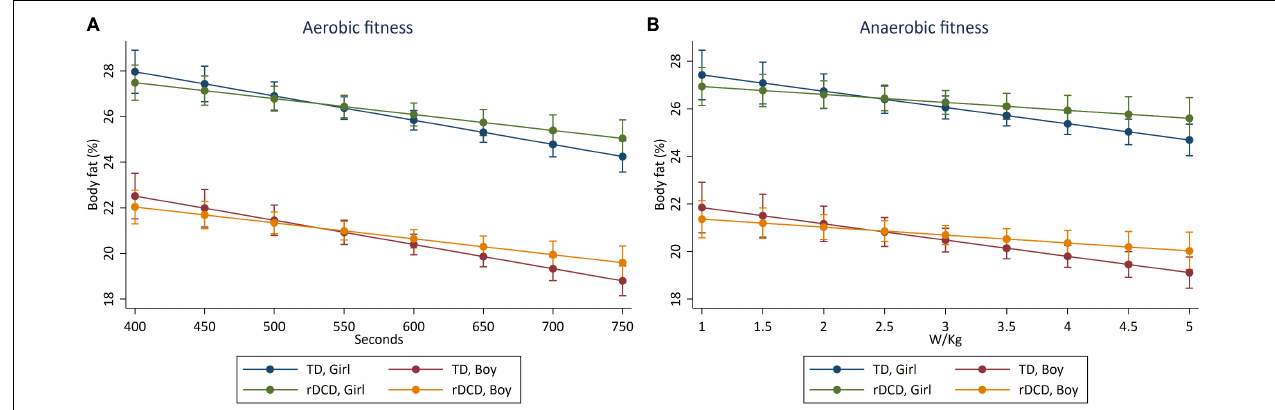
FIGURE 1 | Predictive margins for reductions in body adiposity (%) with increments in (A) aerobic fitness (time on Bruce test, s) and (B) anaerobic fitness [Wingate mean 30 s power (W/kg)]. Cross-sectional association between aerobic fitness (A) and anaerobic fitness (B) with body adiposity in boys and girls classified as TD and rDCD. The highest values on the x -axes represent the 95th percentile of aerobic fitness (A) and anaerobic fitness (B) distributions.